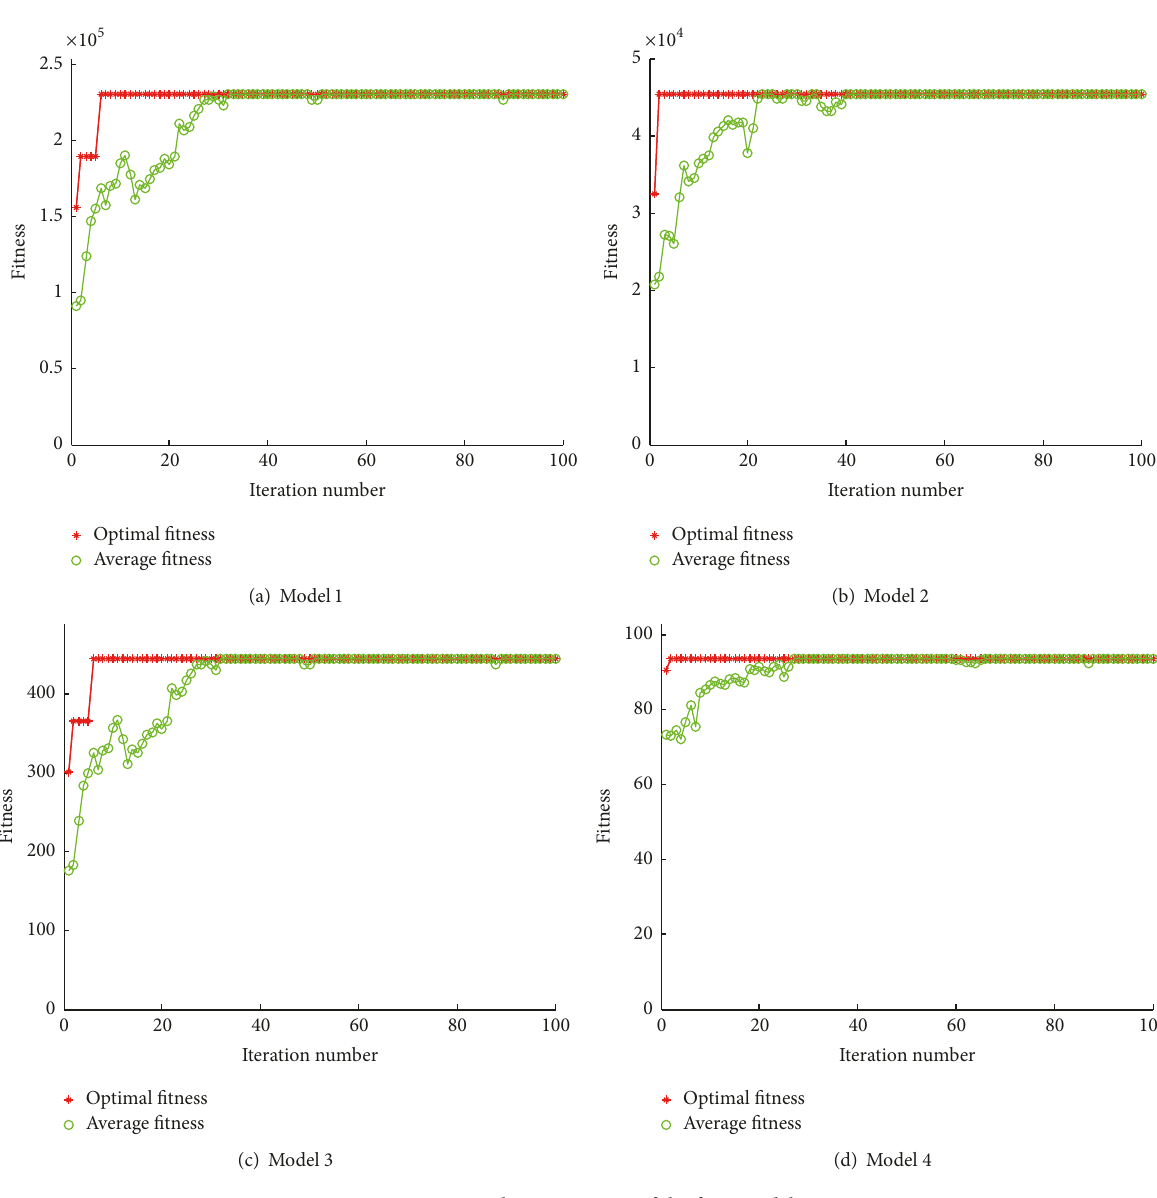
Figure 11: Results comparison of the four